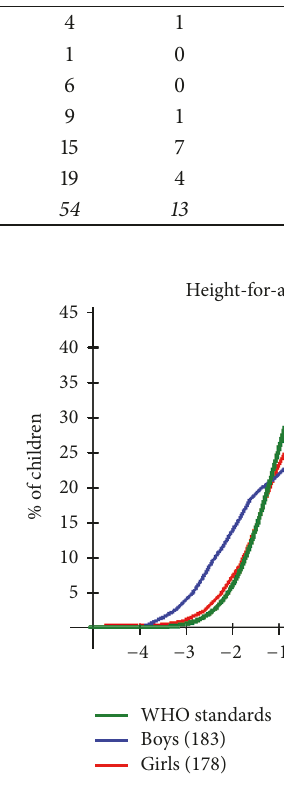
Figure 2: A plot of height for age 𝑍 -scores by gender for the PSAC in Mwea Division against the WHO recommended